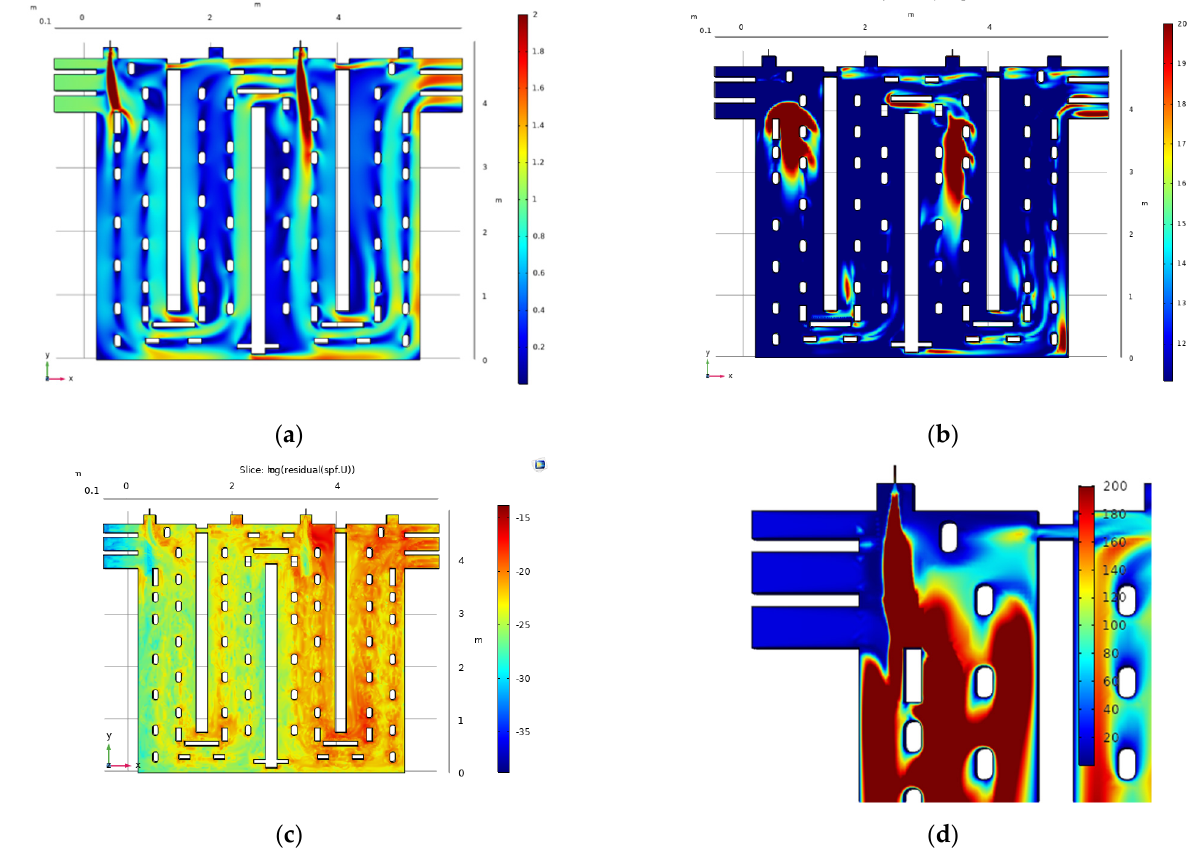
Figure 9. Model 6: isotropic diffusion with δ = 0.005, using mesh 2. Inlet velocity of fuel: 70 m/s. Viscosity 1.8 × 10 − 5 Pa·s. ( a ) Velocity field (dimensions m/s); ( b ) Wall resolution in viscous units; ( c ) Residual plot; ( d ) Turbulent viscosity ratio. Model 7: artificial diffusion is used with the aim of achieving convergence. Figure 10 presents the velocity slide plot. The velocity plot shows that there are thin streams with high velocity. Few high-velocity streams are produced by two factors: (1) intersection of faces—as error message—was obtained when refining the whole combustion zone when using the mesh generation techniques inside COMSOL Multiphysics; (2) low convection due to the presence of false-added diffusion. Thus, the physical interpretation indicates that the solution corresponds to a nearby problem due to the use of artificial diffusion.